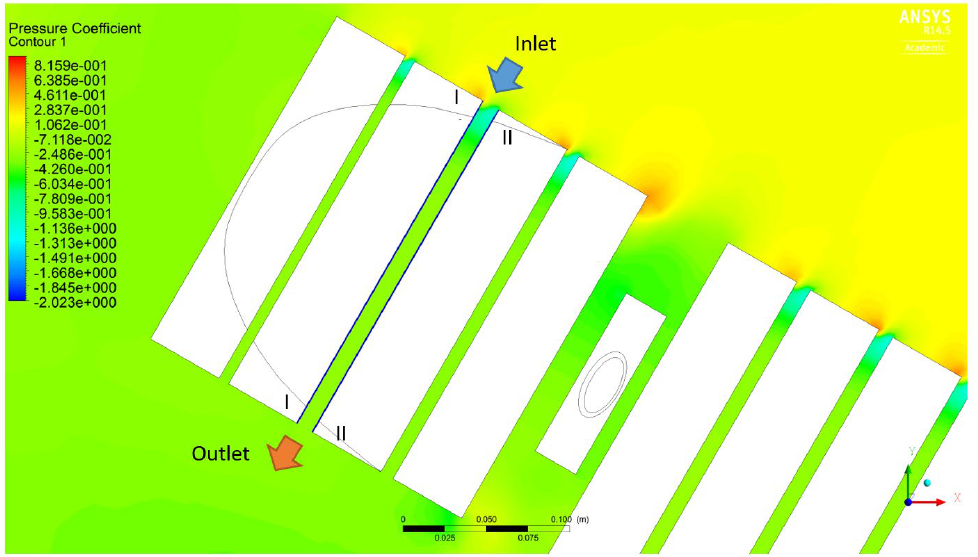
Figure 15. Pressure distribution in and around the gap between I-I and II-II.